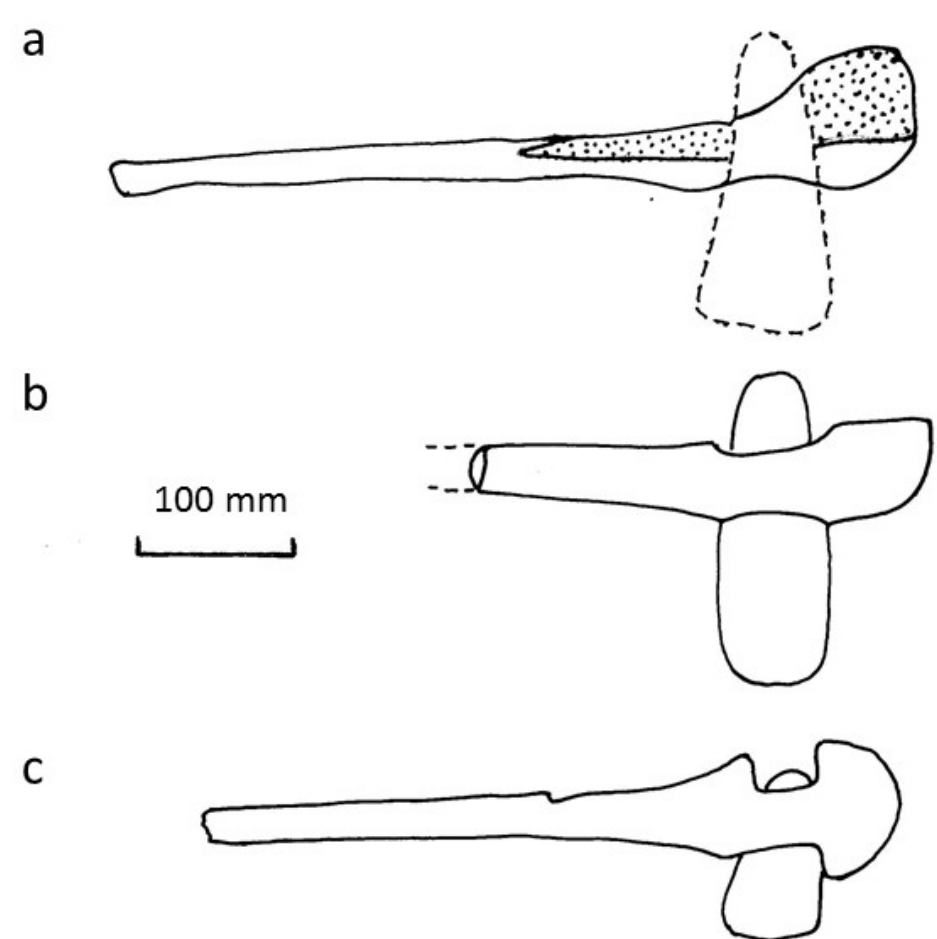
Figure 7. Neolithic axe hafts from Britain (redrawn from Harding 2014, fig. 1). a) The axe from Etton, Cambridgeshire (Taylor 1998: fig. 162). The handle had broken at the edge of the socket, splitting to reveal new surface (dotted area) and releasing the supposed axehead (dashed line). b) the axe from Ehenside tarn Cumbria (Evans 1897: fig. 92). c) The Shulishader axe from Lewis (Sheridan 1992: fig. 78). Note the flanges at the distal and (in b and c) the proximal end of the